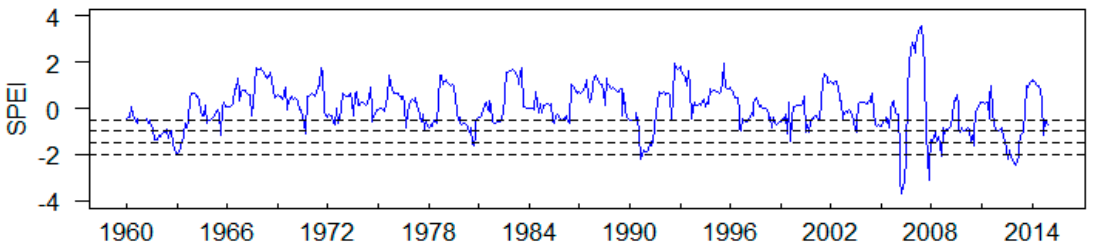
Figure 3. SPEI series at YC station based on the TH equation. Four dotted lines from top to bottom represent the thresholds of four drought levels: Light, moderate, severe, and extreme droughts, respectively. Table 4. The drought events numbers for all stations in HIRB.